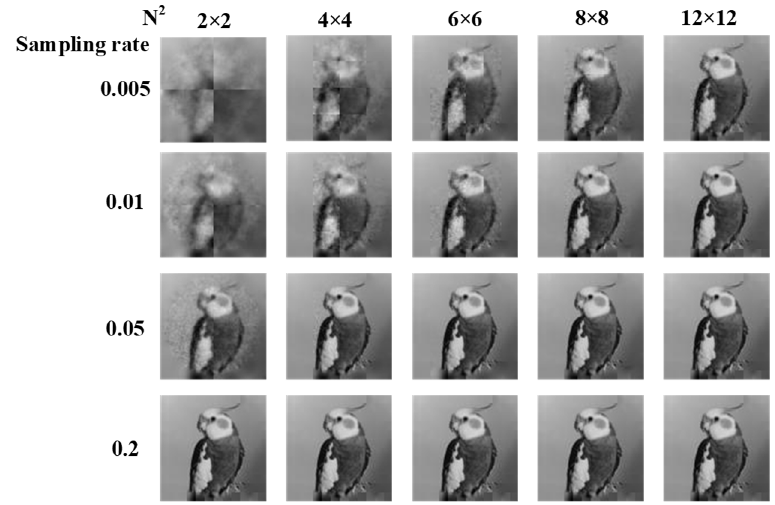
Figure 7. Reconstructed results of ‘PRGI’ under different image sizes and different block sizes.